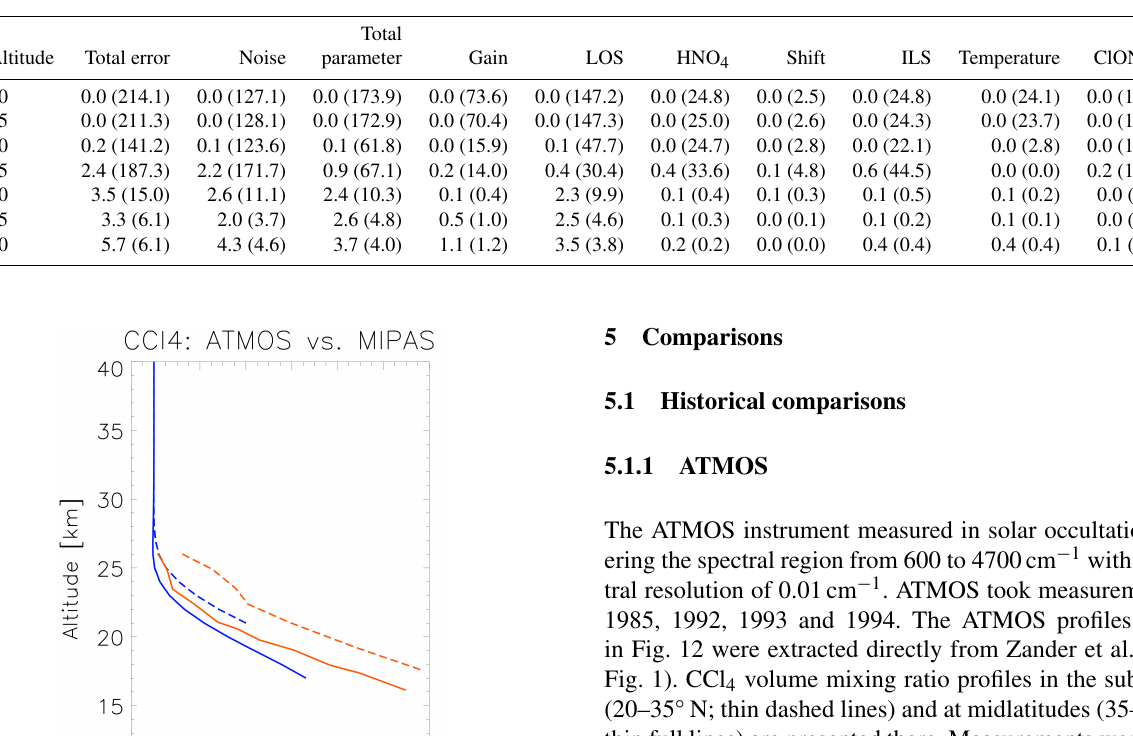
Table 3. Error estimates for a midlatitude profile during the RR period. Errors are given in pptv (relative errors in %).